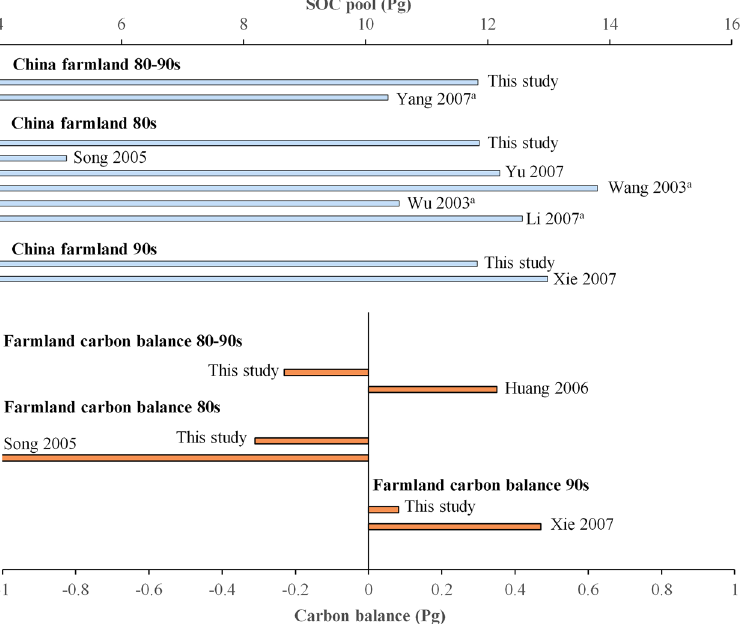
Figure 1. SOC balance on Chinese cropland. The figure was generated using Microsoft excel 2016 software provided by Microsoft office. a Calculated based on a depth of 1 meter and 15% (Li & Zhao, 2001; Yu et al ., 2007) of the total national soil carbon stored in agricultural